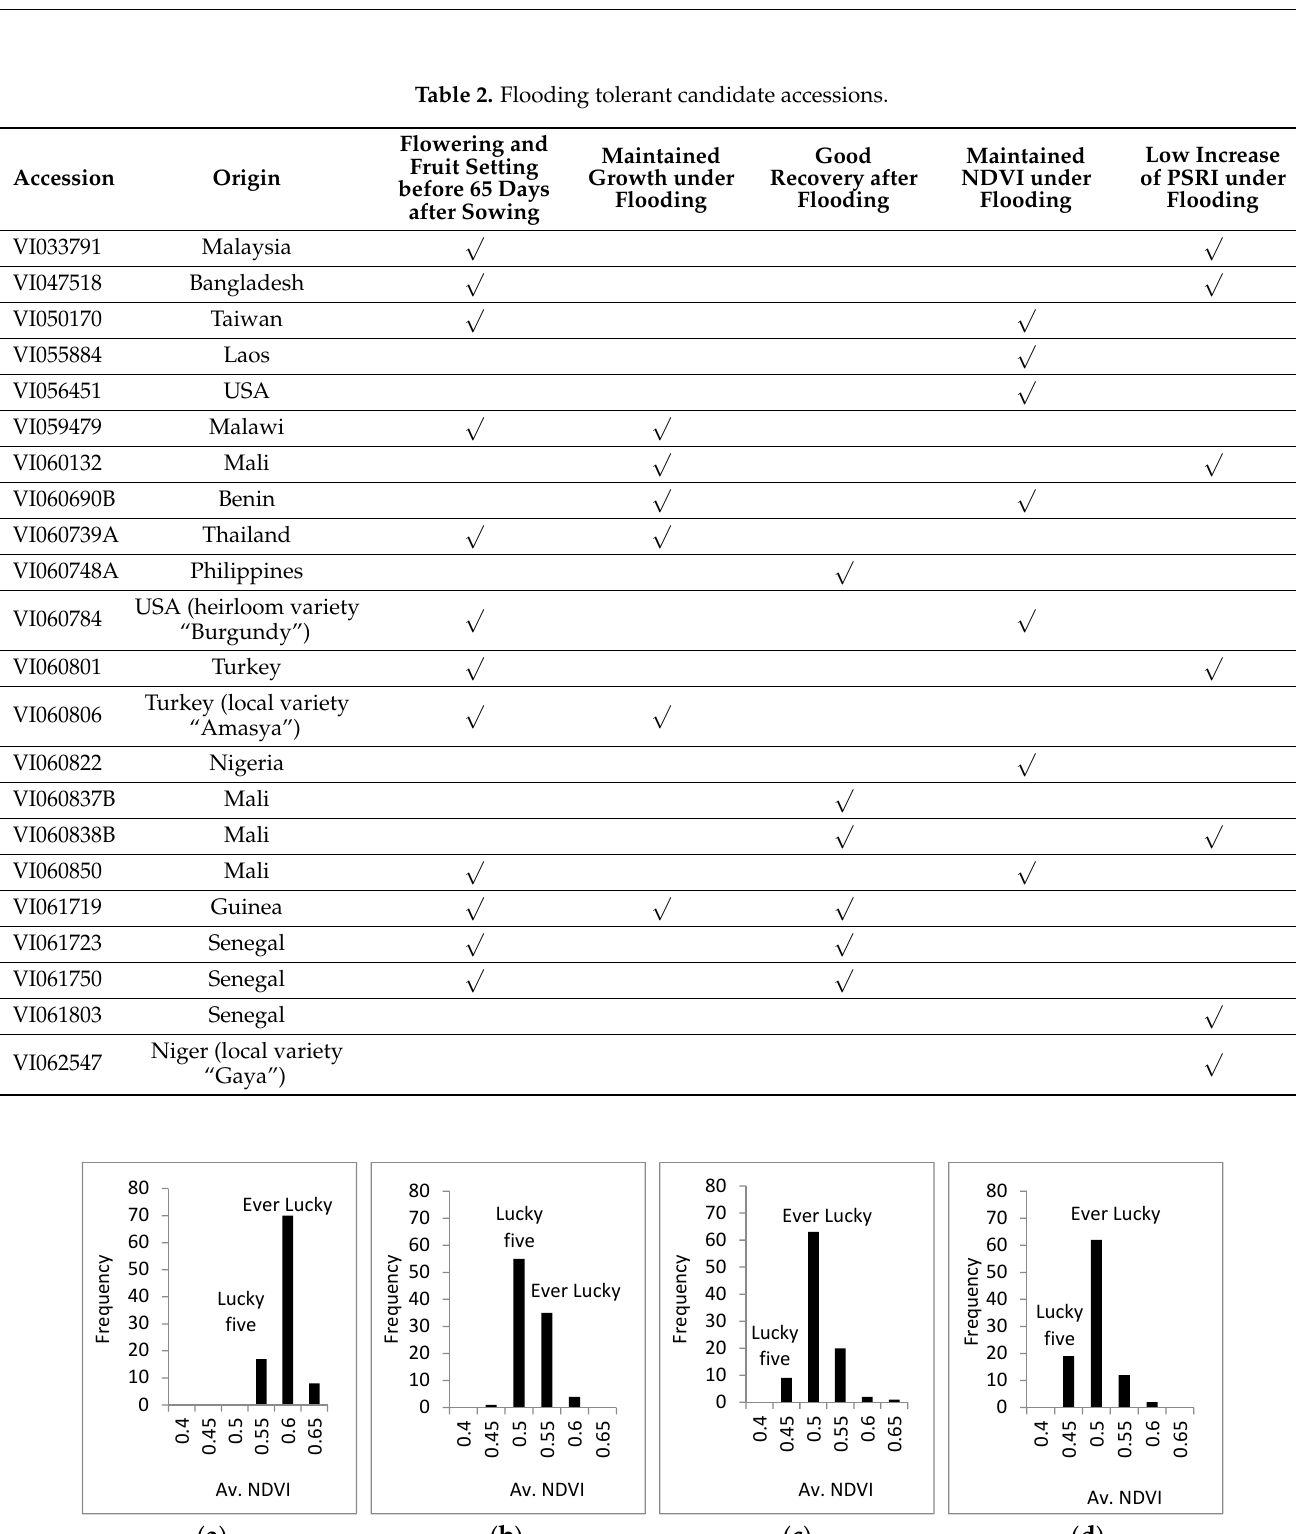
( d ) Figure 7. ( a ) Frequency distribution of average PSRI ( a ) before flooding, ( b ) during flooding, ( c ) during early recovery, and ( d ) during prolonged recovery. The commercial checks are attributed to their PSRI bin.